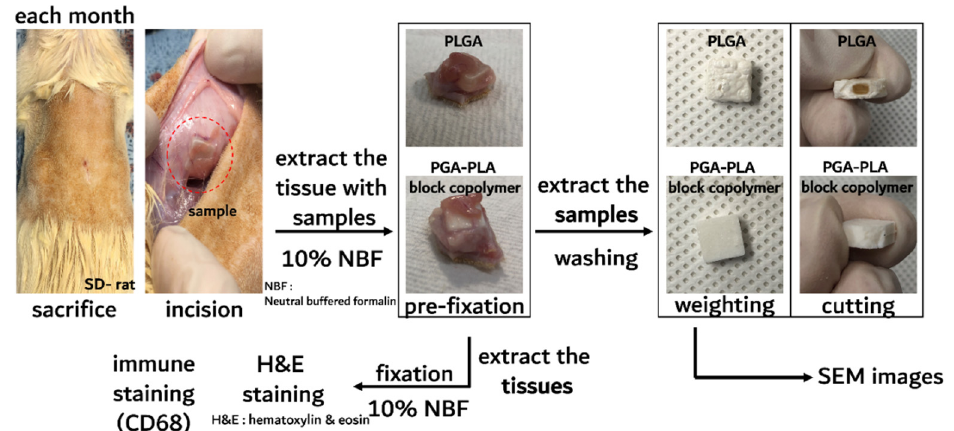
Figure 6. Schematic image of in vivo animal-degradation test showing sample-extraction procedure and samples after harvesting steps.